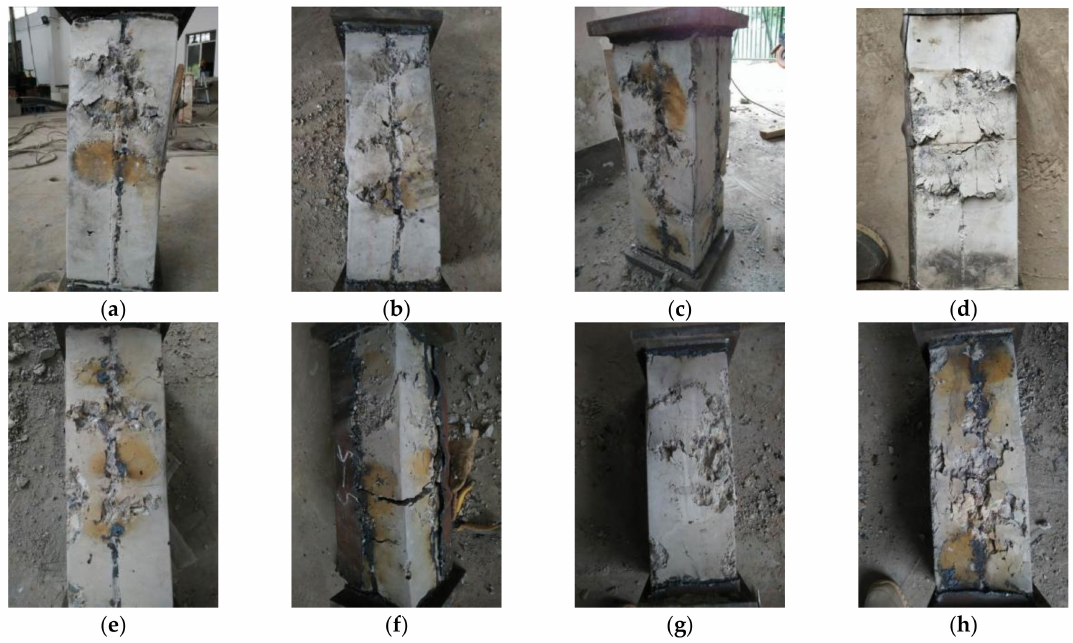
Figure 5. View of specimens after opening steel tubes ( a ) DS-20; ( b ) DS-100; ( c ) DS-200; ( d ) DS-200-0; ( e ) DS-400; ( f ) DS-600; ( g ) DS-600-0; ( h ) DS-800.